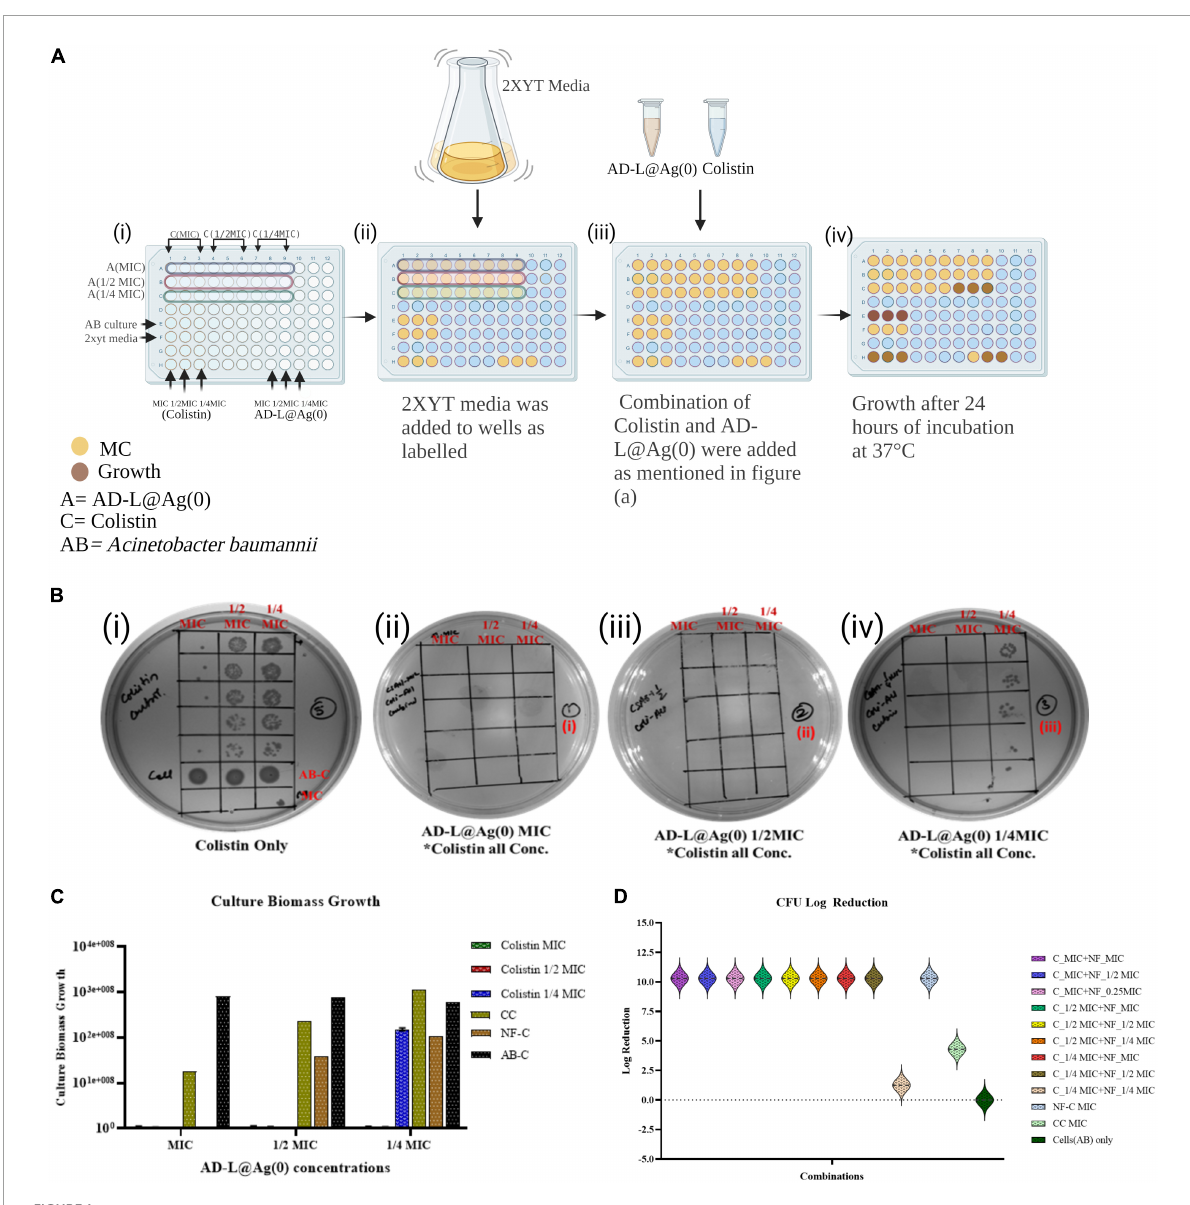
FIGURE1 Minimum inhibitory concentration (MIC) calculation: The MIC, 1 / 2 MIC and 1 / 4 MIC of colistin (MIC col ), of AD-L@Ag(0) nano-formulation [MIC ADL@Ag ( 0 ) ] and that of combination [MIC Col + MIC ADL@Ag ( 0 ) ] against Acinetobacter baumannii (AB) was checked using spot assay, CFU count, and by optical density (OD) analysis. The growth of ABin the presence of all the concentrations of colistin confirms resistance. (A) Schematic representation of the checkerboard assay at various MICs of colistin and AD-L@Ag(0) to test their synergy or additive effect. (B) Spot assays for calculation of MICs: (i) Plate showing growth of ABin the presence of all the MICs of colistin with controls; AB-C, AB control; MC, media control (ii) plate showing effect of the combination of all the MICs of colistin (MIC col , 1 / 2 MIC col , 1 / 4 MIC col ) + MIC of AD-L@Ag(0) on the growth of AB (iii) plate showing effect of the combination of all the MICs of colistin (MIC col , 1 / 2 MIC col , 1 / 4 MIC col ) + 1 / 2 MIC of AD-L@Ag(0) on the growth of AB (iv) plate showing effect of the combination of all the MICs of colistin (MIC col , 1 / 2 MIC col , 1 / 4 MIC col ) + 1 / 4 MIC of AD-L@Ag(0) on the growth of Acinetobacter baumannii . (C) Culture Biomass Growth measured from absorbance (OD 600 ) at various combinations of MICs of colistin and AD-L@Ag(0). The X -axis of the histogram represents MIC, 1 / 2 MIC, and 1 / 4 MIC of AD-L@Ag(0), whereas the Y -axis shows the culture biomass growth at these MICs. The color bars represent different concentrations of colistin (MIC, 1 / 2 MIC, and 1 / 4 MIC) with controls: CC, colistin control; NF-C, nano-formulation control [AD-L@Ag(0)]; AB-C, Acinetobacter baumannii control. (D) This figure shows the log reduction in CFU count of AB after treatment with different combinations of colistin and AD-L@Ag(0). The Y -axis shows the log reduction of CFU/ml. X -axis shows different colors representing various combinations of colistin (MIC, 1 / 2 MIC, and 1 / 4 MIC) with multiple concentrations (MIC, 1 / 2 MIC, and 1 / 4 MIC) of AD-L@Ag(0), along with controls: CC, colistin control; NF-C, nano-formulation control [AD-L@Ag(0)]; AB-C, Acinetobacter baumannii